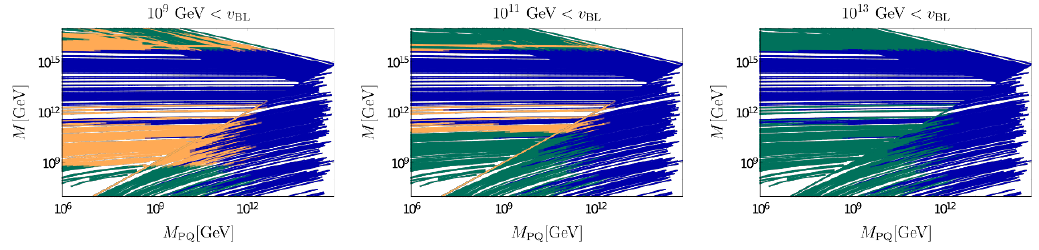
Figure 8 . Intermediate scales M PQ and M BL and GUT-scale M U for Model 2.2 for di(cid:11)erent threshold corrections. The curves in blue are excluded by gauge-mediated proton decay limits, the curves in green by the limit on the B-L breaking scale. We have considered three di(cid:11)erent ranges of allowed B-L breaking scales. The threshold corrections are randomised in the following way: all scalars take masses among the values f 1 ; 1 ; 10 g times the corresponding threshold scale, where we 10 have taken care not to make proton decay mediating scalars contained in the (6 ; 2 ; 2) (Pati-Salam) multiplet